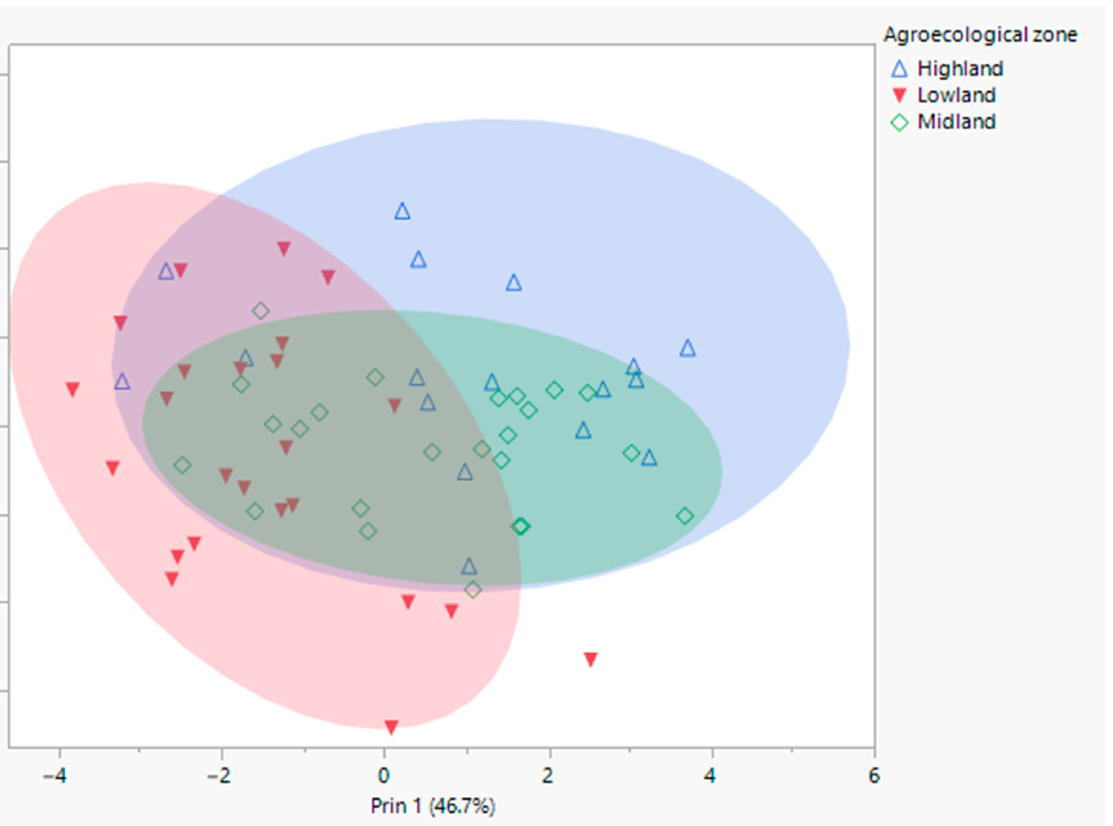
Figure 2. Scatter plot of principal component scores of this study’s samples assigned to their agro-ecological zone (highland, midland and lowland). Scores were generated from nine morphometric characteristics: forewing length, forewing width, femur, tibia, metatarsal length, metatarsal width, total length of hind leg, cubital vein distance a and cubital vein distance b.